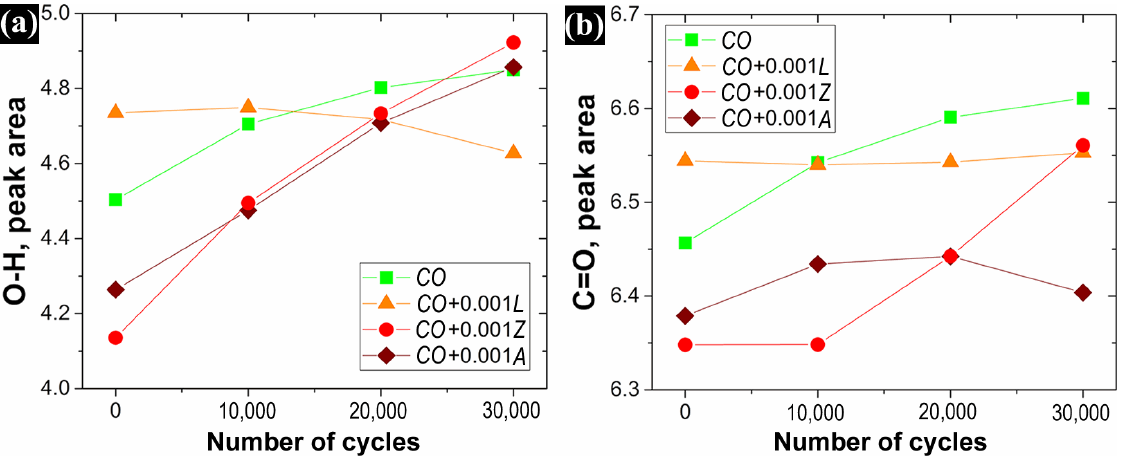
Figure 11. Effect of xanthophylls in CO over its hydroxyl and carbonyl groups signal.